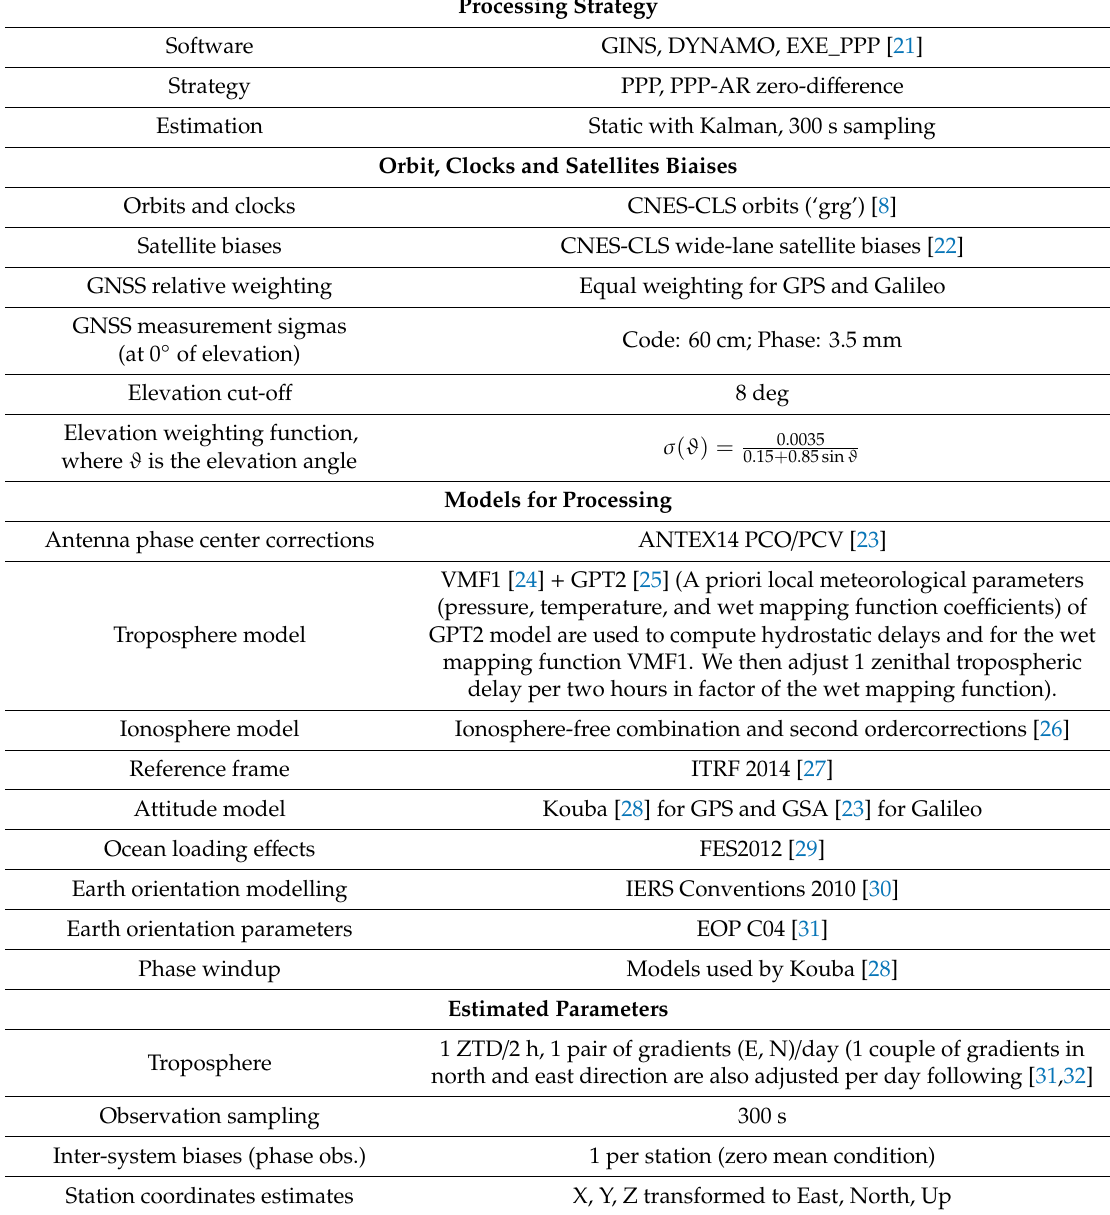
Table 2. Parameters, models and strategy of